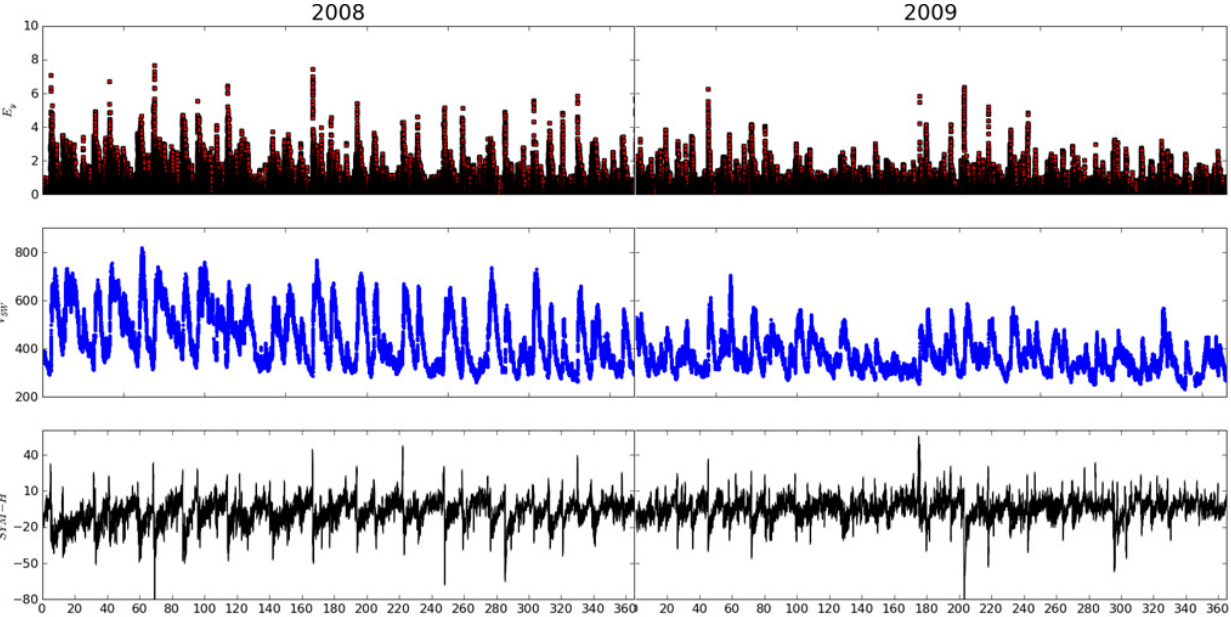
Fig. 4. Solar wind parameters for 2008–2009: (a) geoeffective IEF E y (as positive value), (b) the solar wind speed and (c) SYM-H index. The convection IEF E y is calculated with the solar wind flow velocity and